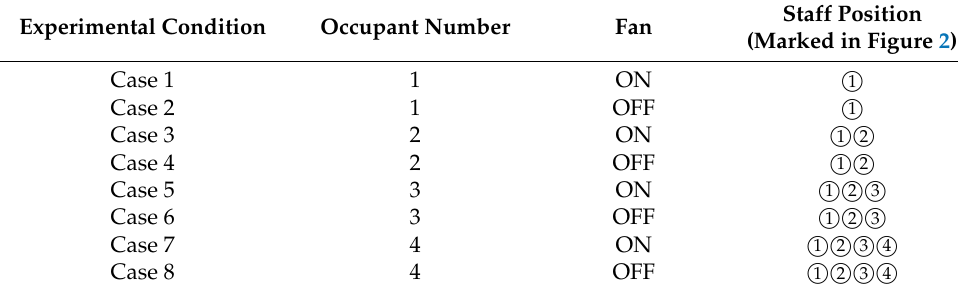
Table 5. The experimental